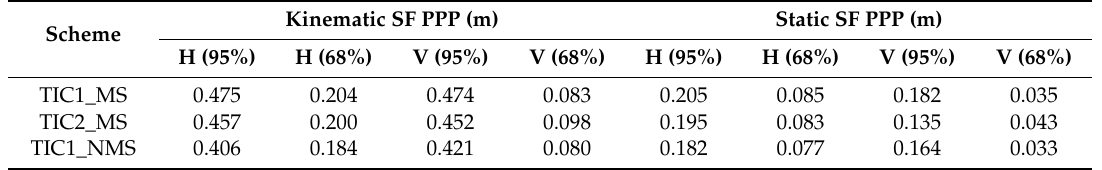
Table 3. The RMS of GPS static and kinematic SF PPP in MS and NMS of TIC1 or TIC2.